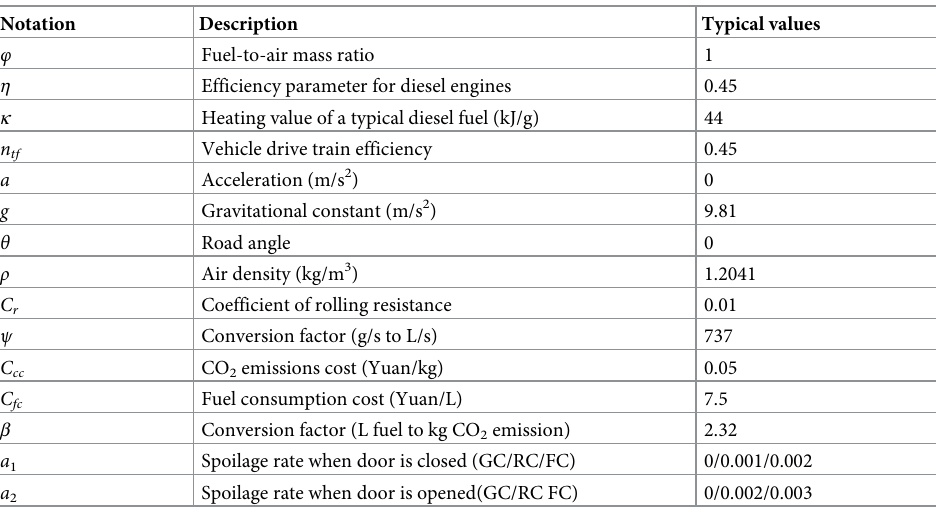
Table 1. Parameters in the proposed model.